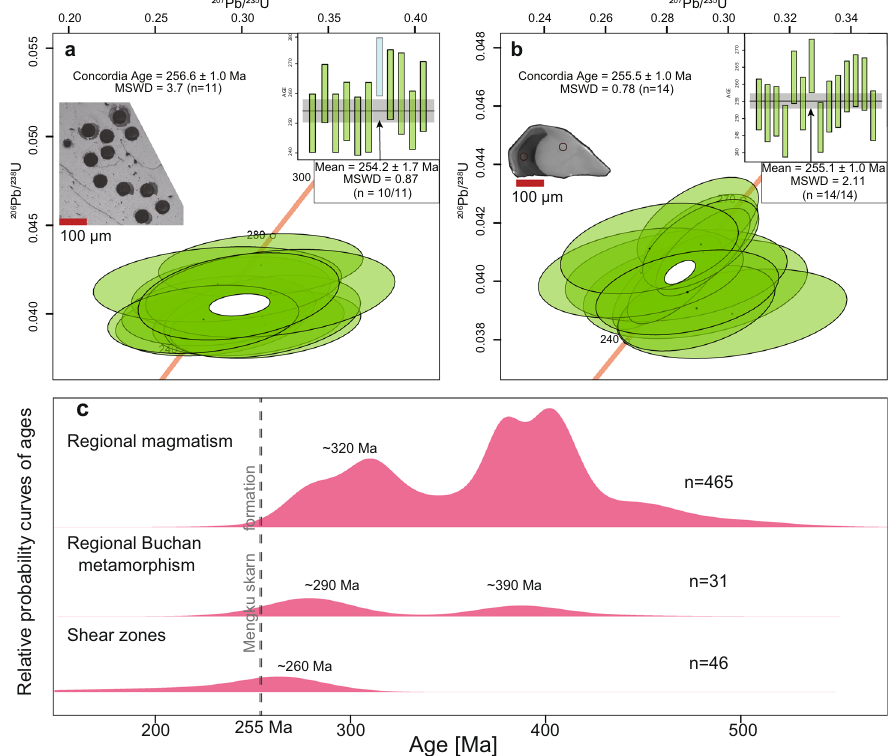
Figure 3. ( a ) The LA-ICP-MS U-Pb result of garnet with concordant and weighed mean ages. The blue bar was excluded from the calculation. ( b ) The Uranium-lead SIMS measurement of a representative zircon with concordant and weighed mean ages. Red circles show the location of geochronological points. ( c ) The age distributions of regional magmatism, metamorphism and shear activities in the Chinese Altai, n = number of ages from 14,15,22–26